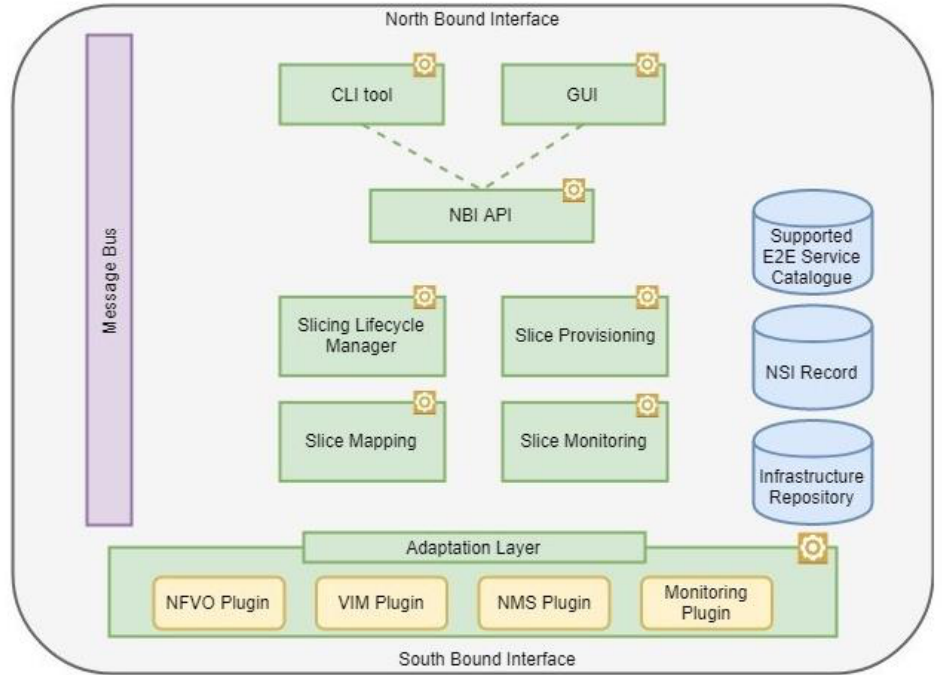
Figure 3. Slice Manager